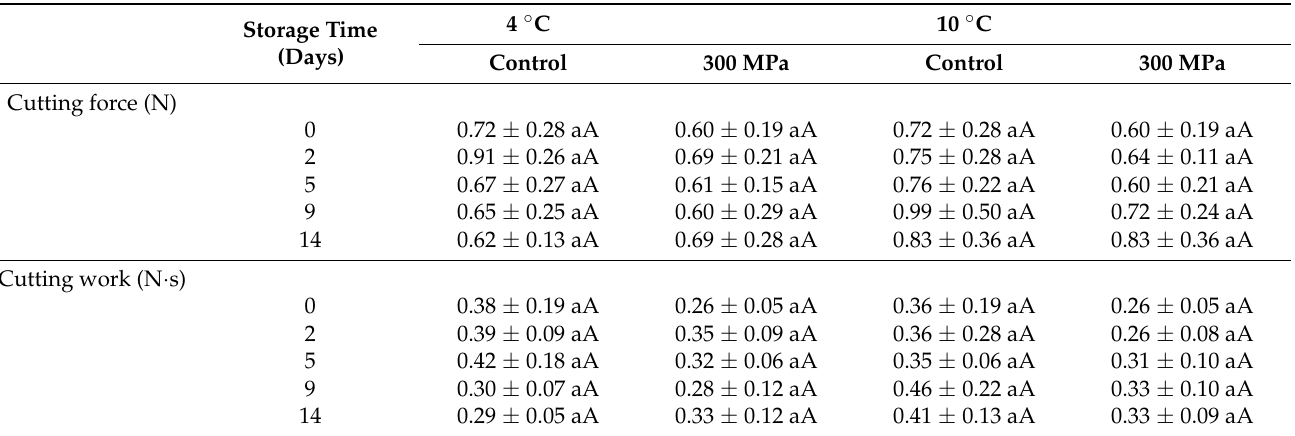
Table 4. Cutting force (N) and cutting work (N · s) values obtained from instrumental texture assess- ment for untreated (control) and HPP oysters (300 MPa for 2 min) over 14 days of storage (sampling points: 0, 2, 5, 9 and 14 days) and at different storage temperatures (4 and 10 ◦